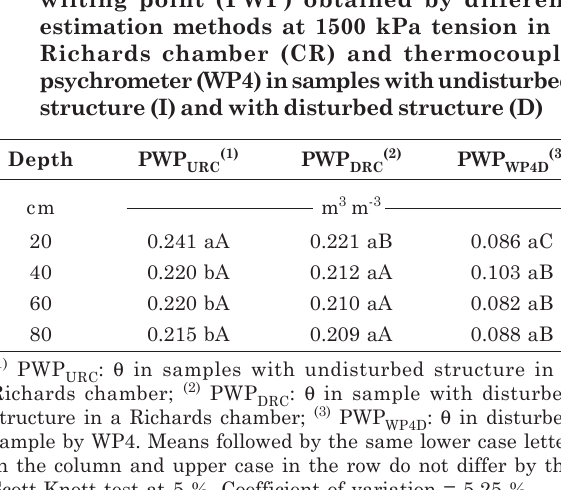
sample by WP4. Means followed by the same lower case letter in the column and upper case in the row do not differ by the Scott-Knott test at 5 %. Coefficient of variation = 5.25 %.